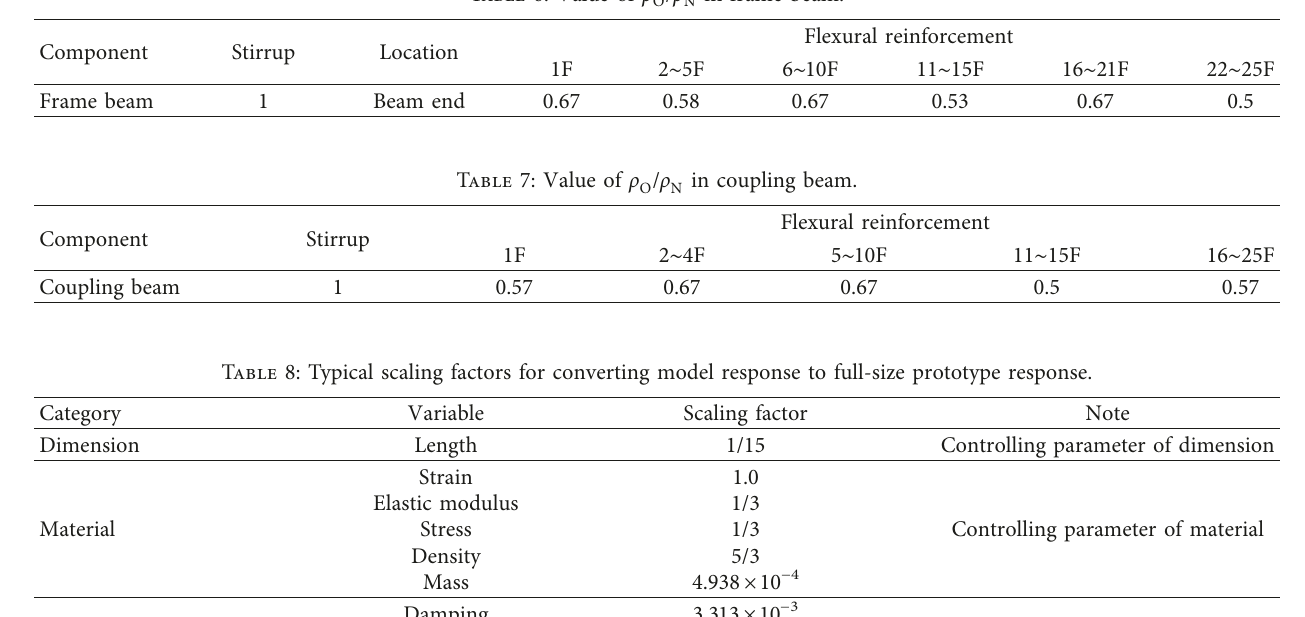
Table 6: Value of ρ